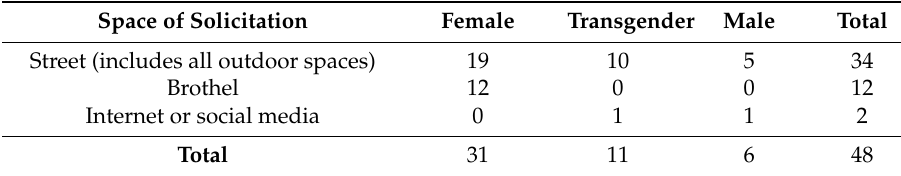
Table 2. Sex worker participant spaces of solicitation in Ecuador by gender.